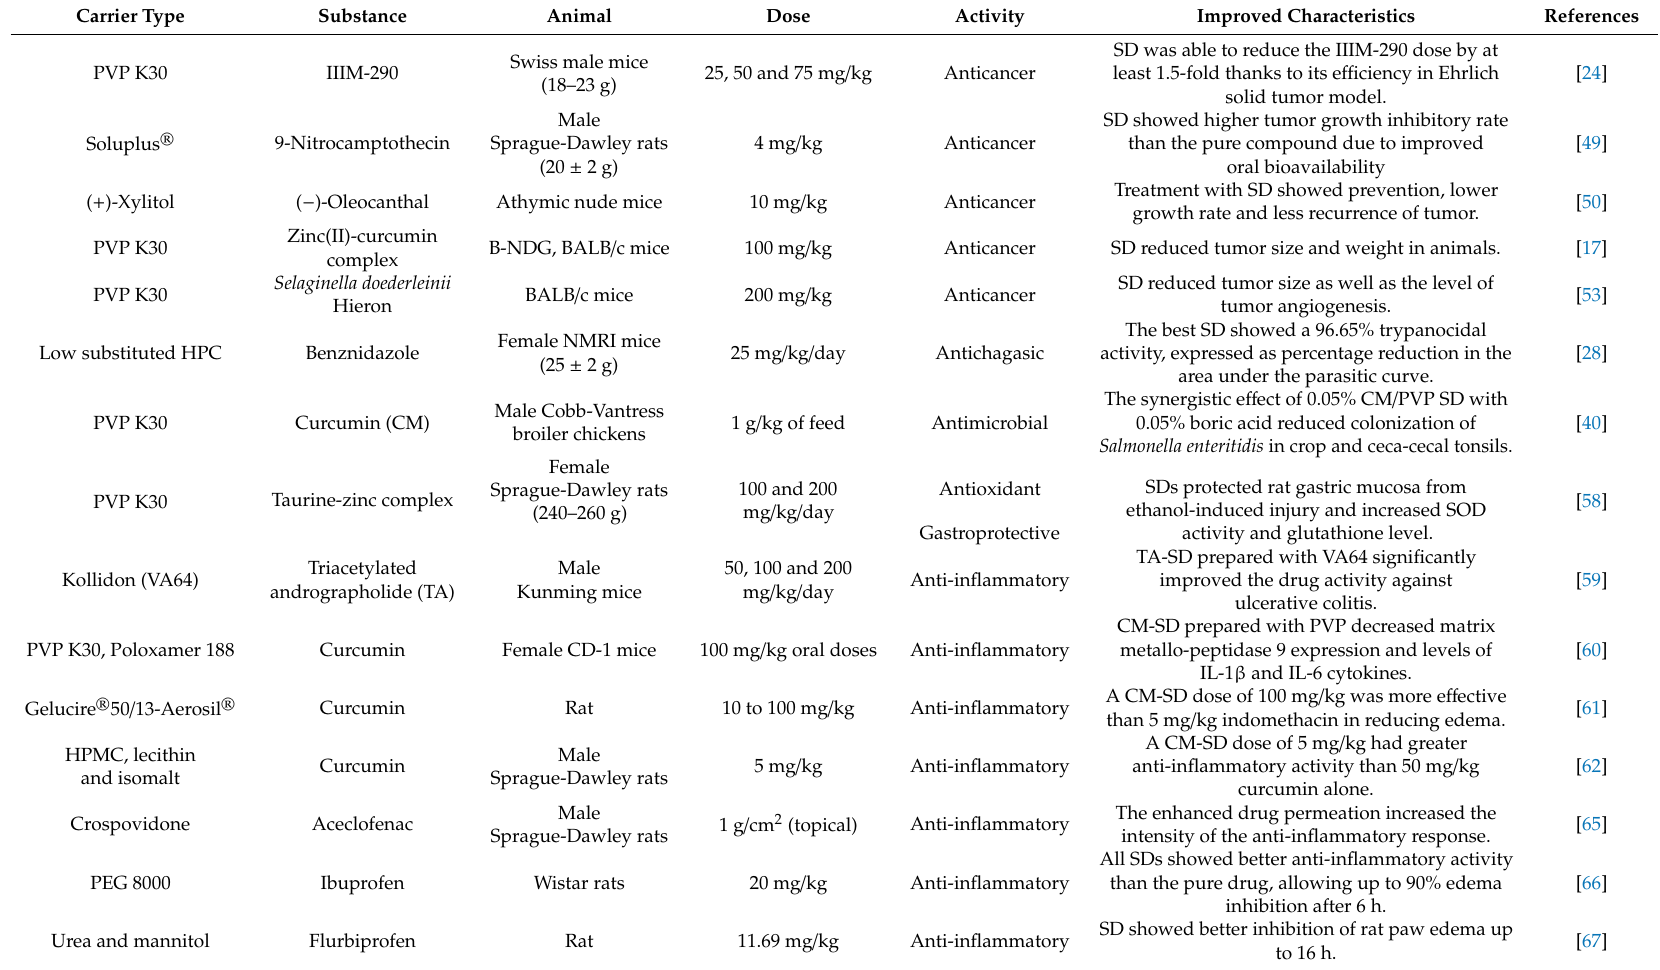
Table 2. In vivo studies on solid